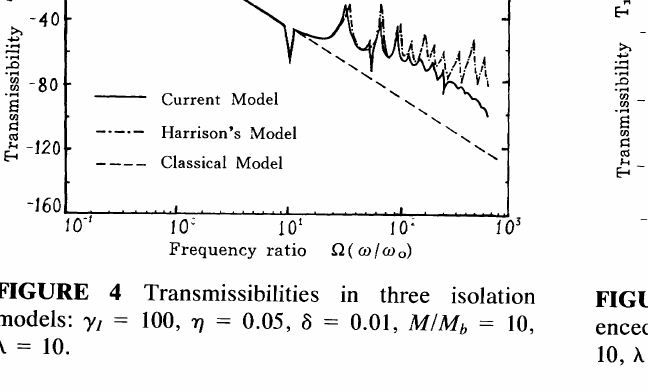
FIGURE 4 Transmissibilities in three isolation models: "II = 100, 'YJ = 0.05, a = 0.01, M1Mb = 10, A = 10.